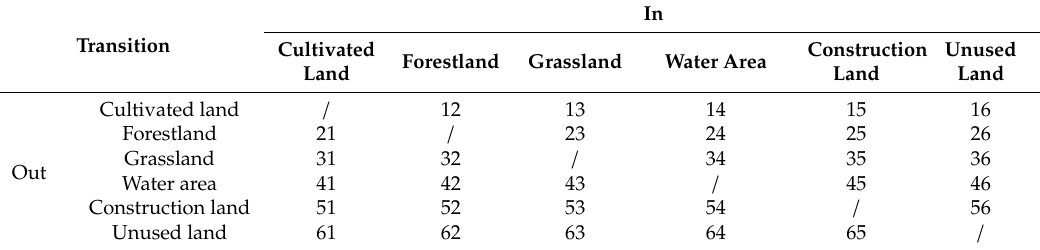
Table A1. The Tupu units’ codes of land use transitions (LUTs) in the